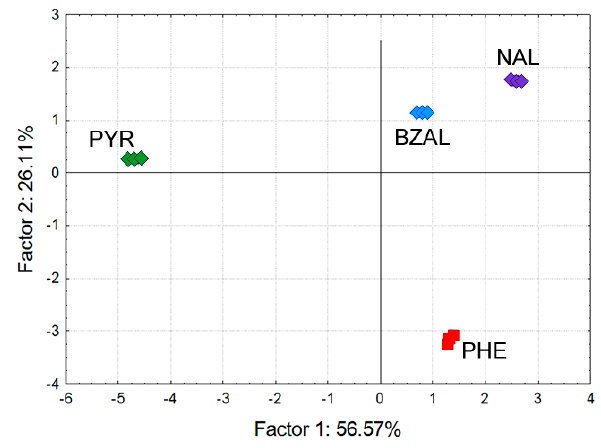
Figure 11. PCA scattering of the 4 odorant samples at 900 ppb obtained upon responses of the 16-channel chemosensitive resistor microchip sensor.